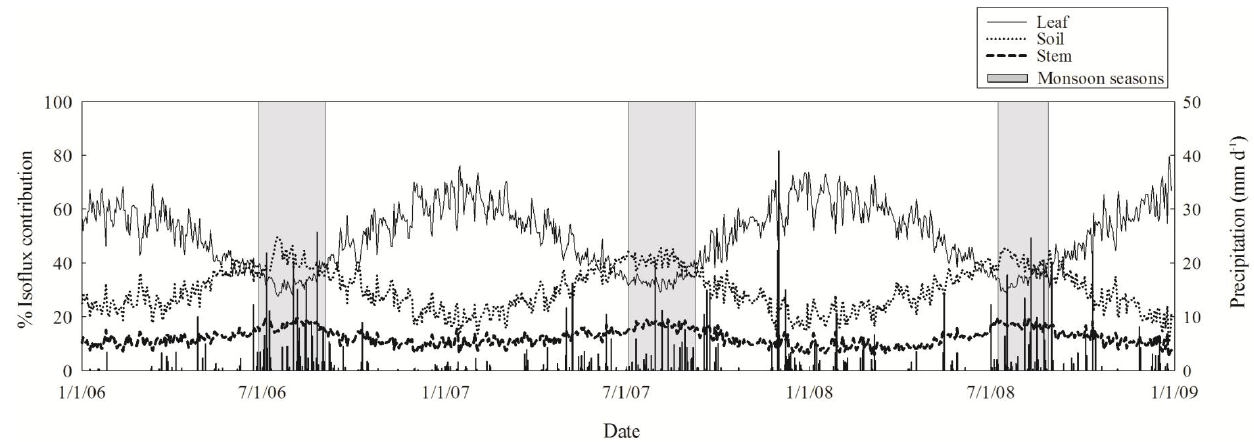
Fig. 7. Time series of foliar, soil, and stem contributions to total ecosystem isoflux derived from ISOLSM. Filled boxes represent monsoon